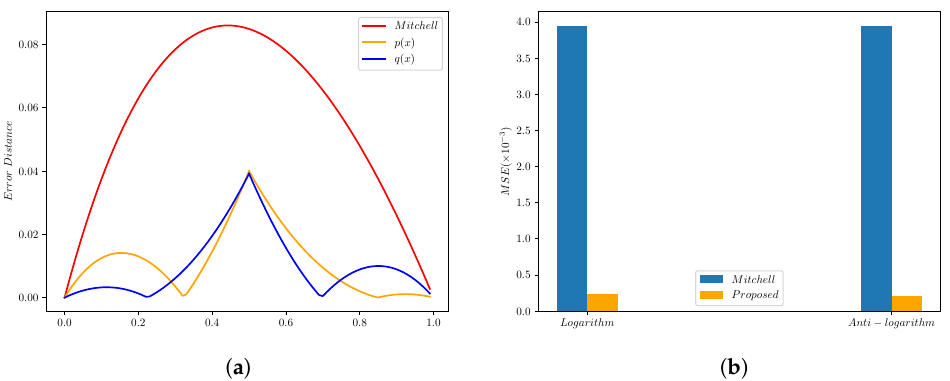
Figure 2. Error metrics comparison of Pwl-Mit and standard Mitchell algorithm. ( a ) Error distance distribution comparison. ( b ) Mean squared error